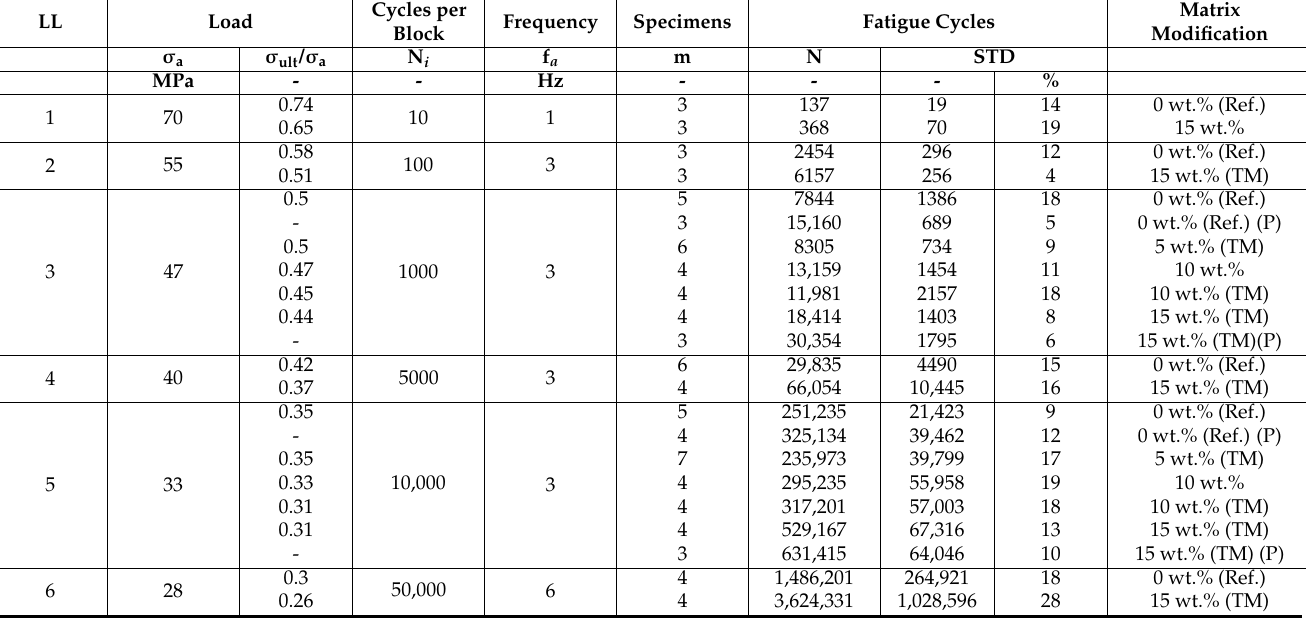
Table 2. Overview of test parameters and fatigue test